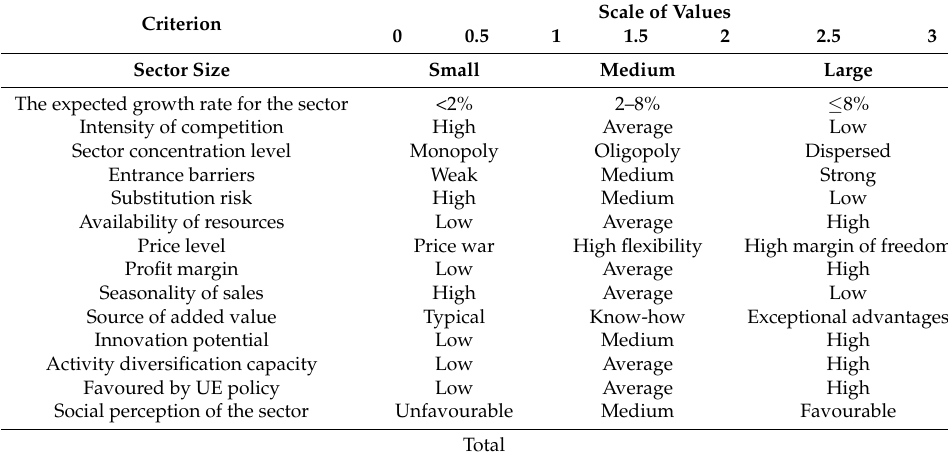
Table 1. Sector attractiveness evaluation grid used in the